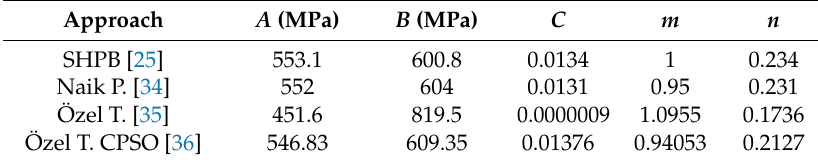
. ε 0 = 1; T r = 25 ◦ C; T m = 1460 ◦